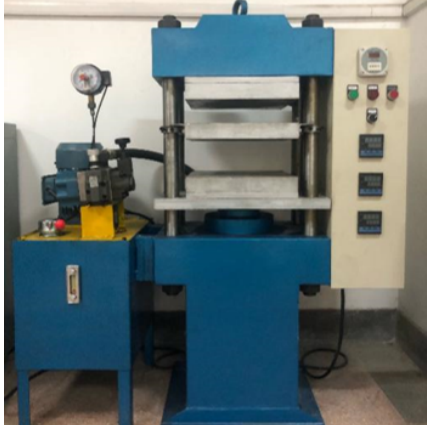
Figure 4: The flat vulcanizer.